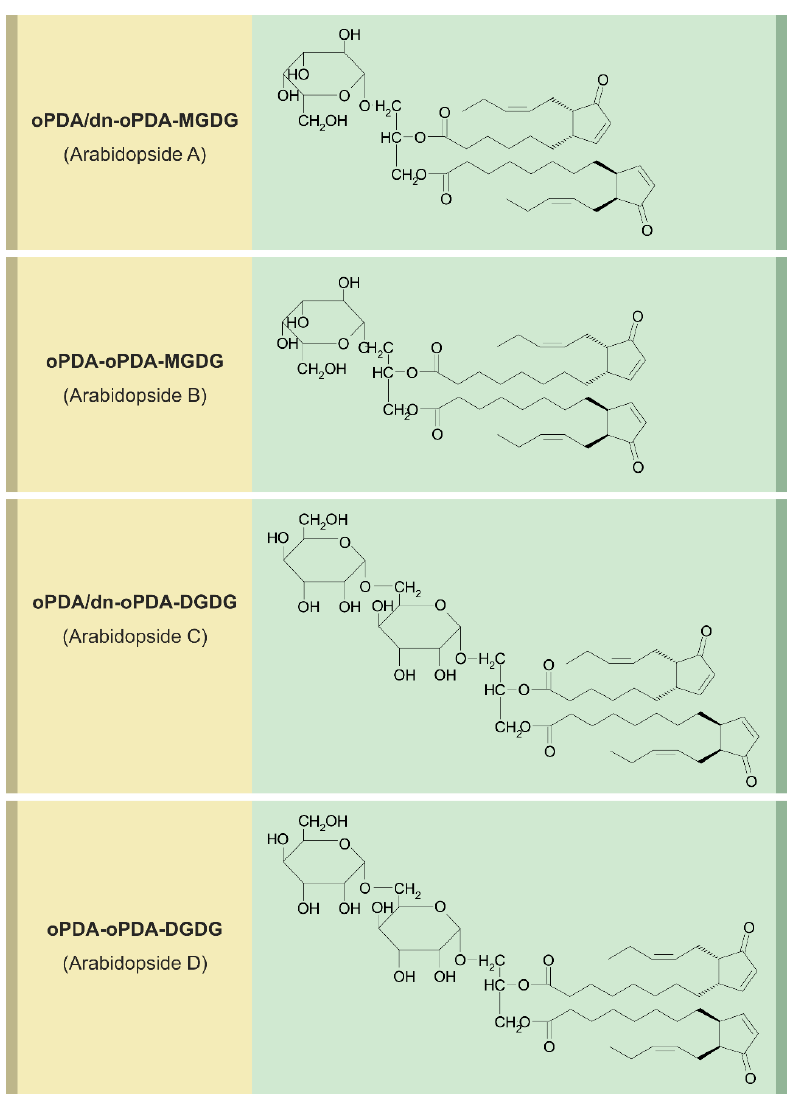
Figure 3. Structures of Arabidopside A, B, C, and